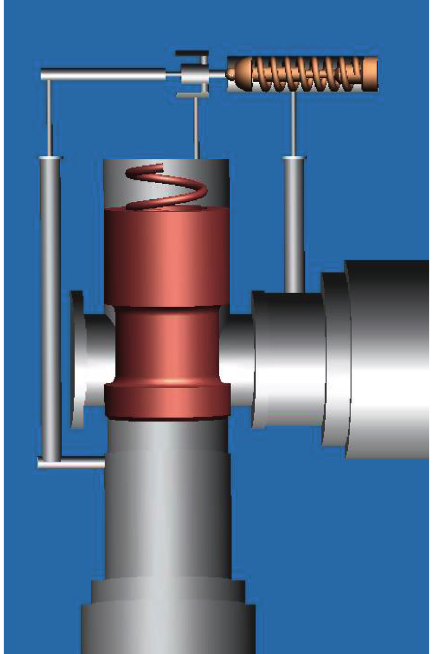
Figure 4: Model of relief valve cavity.